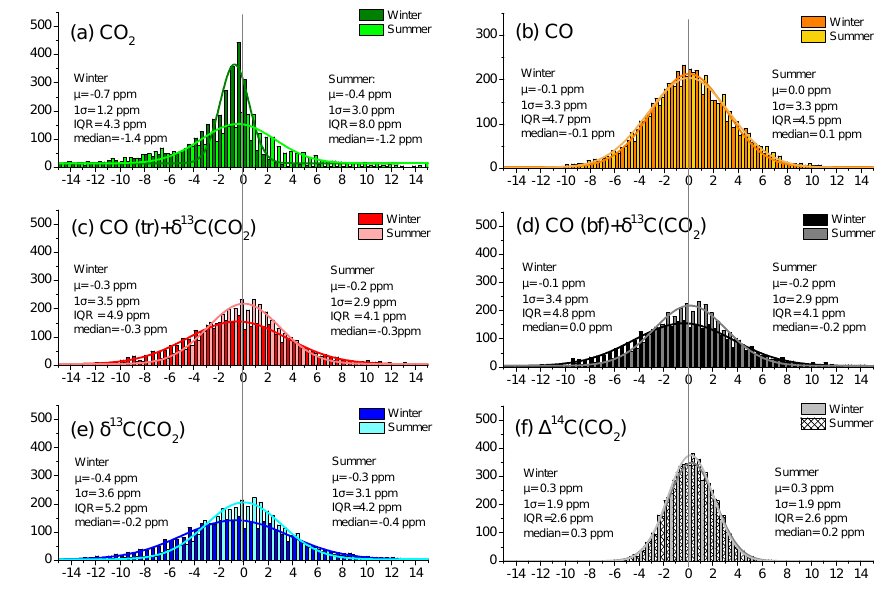
Figure 6. Same as Fig. 2 but now also including measurement imprecision.